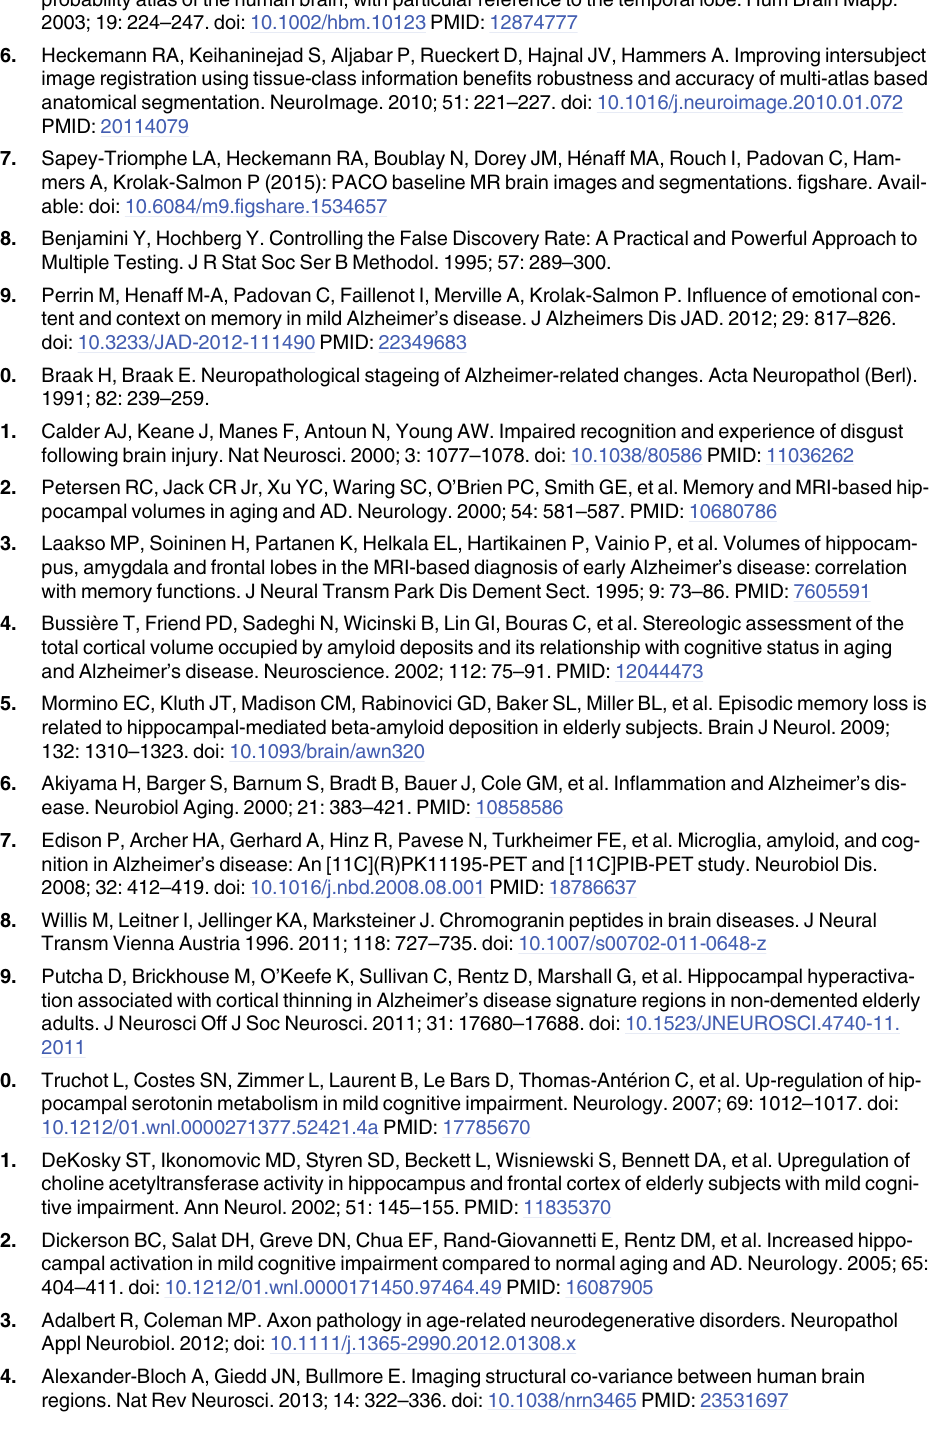
PLOS ONE | DOI:10.1371/journal.pone.0143586 December 16,